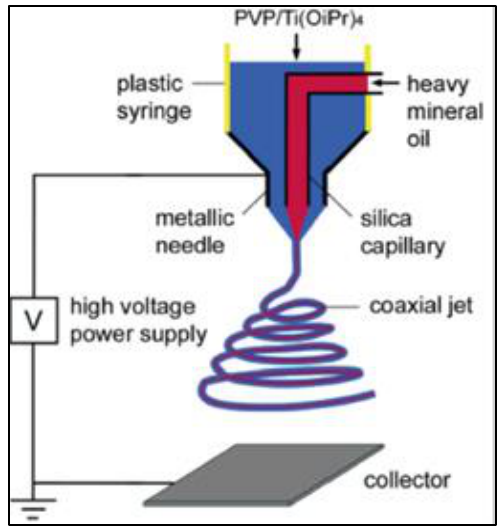
Figure 6. A coaxial electrospinning setup diagram. Li et al. [172].